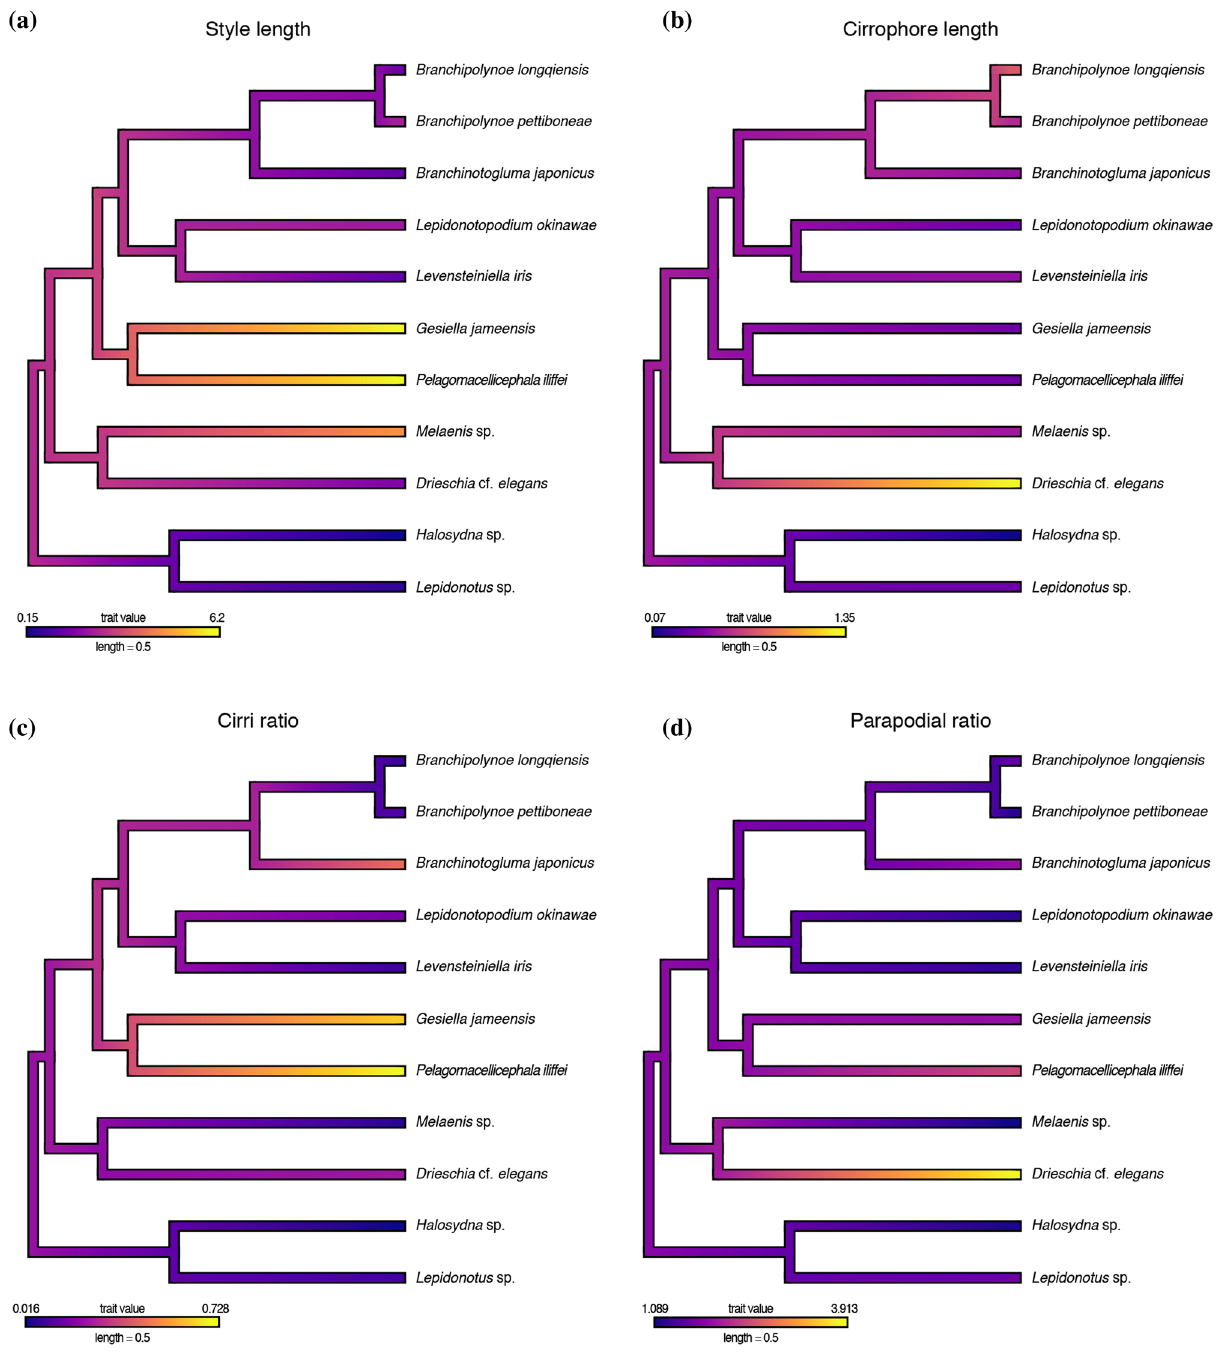
Figure 3. Phylogenetic Generalized Least Square (PGLS) analyses of measured parapodial traits in Polynoidae. ( a ) Continuous character “style length” mapped. ( b ) Continuous character “cirrophore length” mapped. ( c ) Mapped ratio of the “cirri length” to “body length”. ( d ) Mapped ratio of the “parapodial width” to “parapodial length”. Branch colours correlate to measured lengths of selected traits, bright colours (i.e., yellow) indicate large measured values while dark colours (i.e., indigo) represent short measured